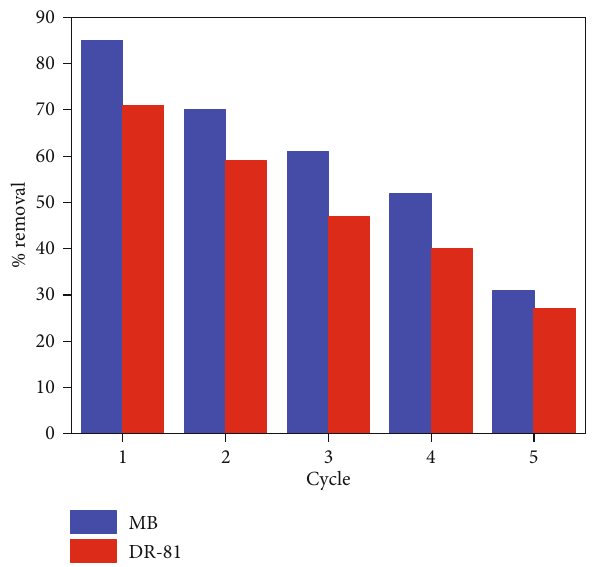
Figure 15: Reusability test of the synthesized Zn-adeninate bio- MOF against cationic and anionic